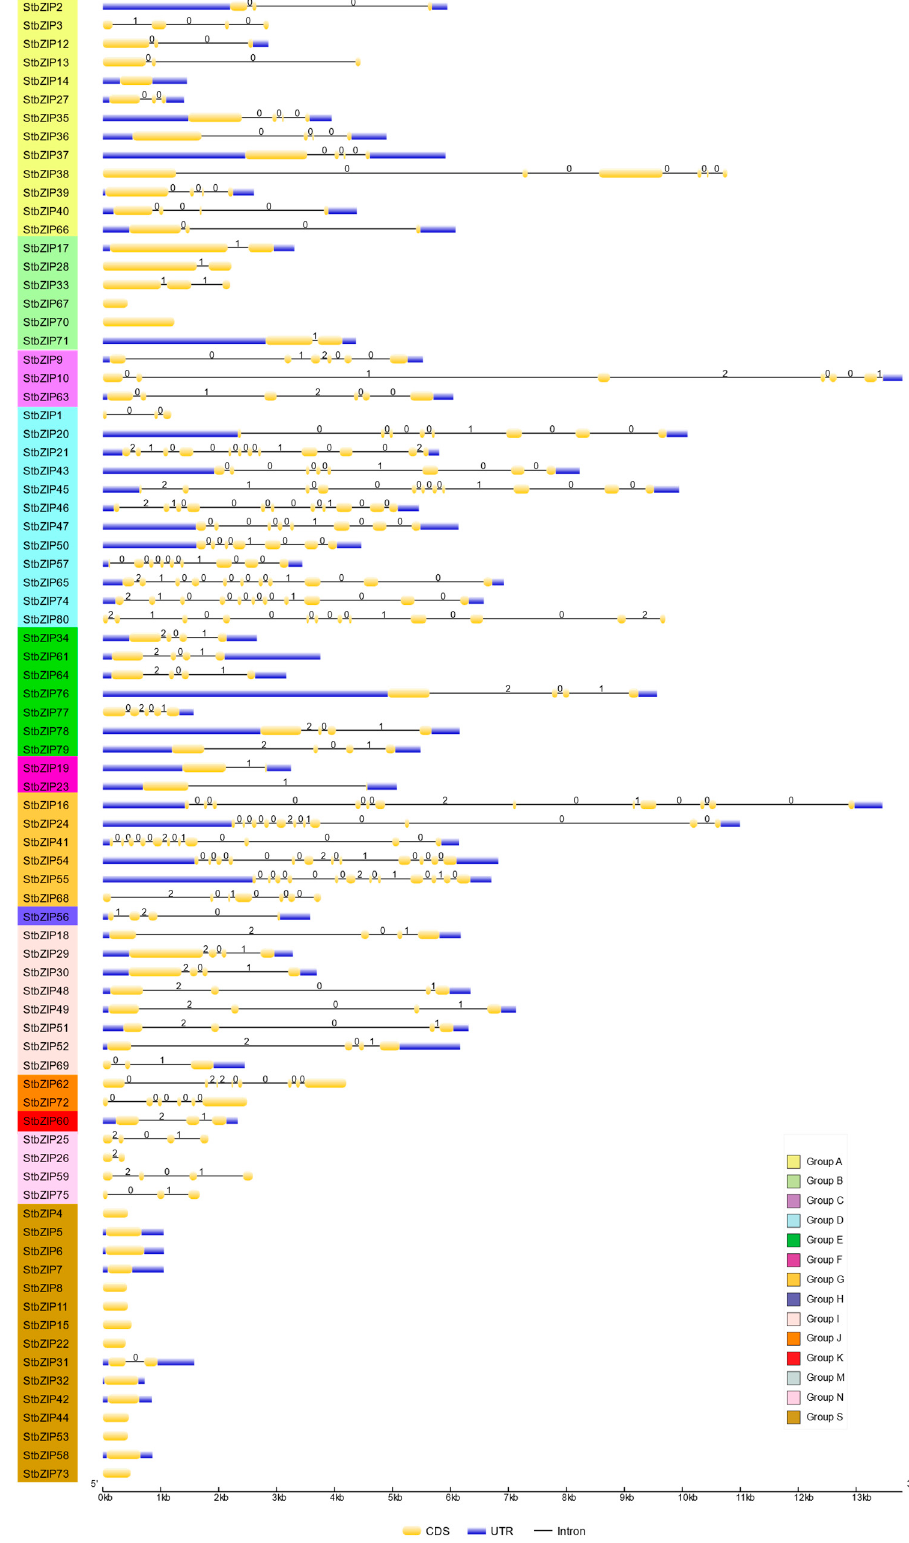
Figure 3. Exon/intron organization of StbZIP genes depicted for each group. The legend in Figure 2 explains the color scheme highlighting gene names. Boxes represent exons, and lines represent introns. The numbers “0”, “1”, and “2” identify the splicing phases.